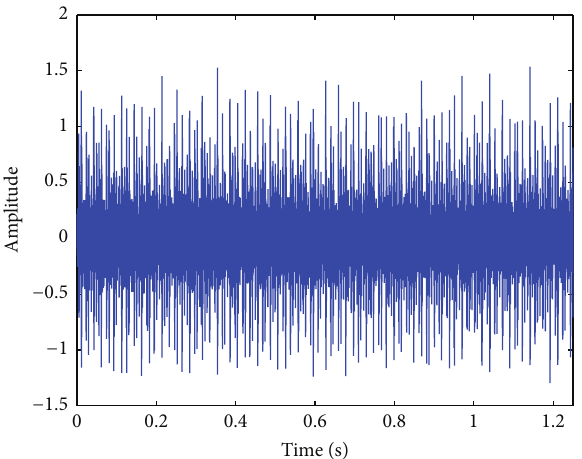
Figure 5: The original vibration signal of faulty bearing in time- domain.